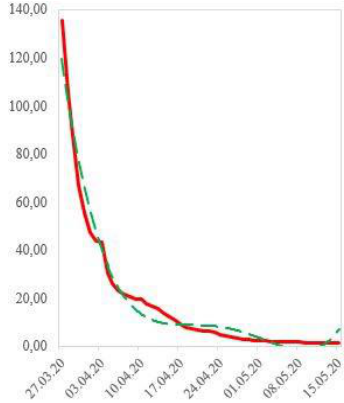
Fig. 5. The ratio of total infected/total recovered with curve fitting.